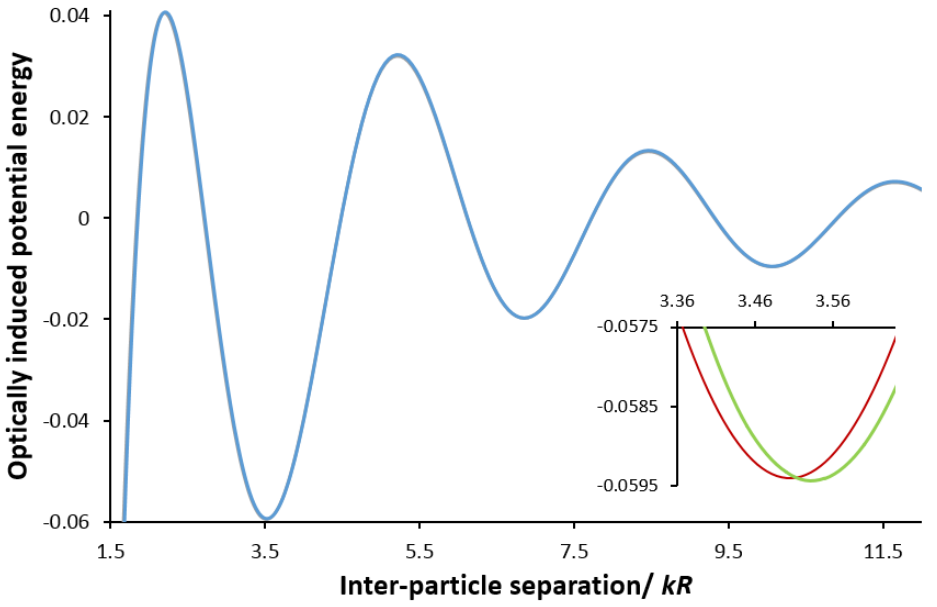
Figure 3. Plot of the optical binding potential energy (in arbitrary units) for two chiral particles in a circularly polarized beam. The abscissa scale measures the inter-particle distance R in dimensionless units of kR , the wave-number k is defined as 2  with   as the laser wavelength. On the scale of the main graph, there is an imperceptible difference between the results for particles whose handedness is either the same, or opposite to, that of the radiation. The inset exhibits the difference between the two cases, around the position of the first potential energy